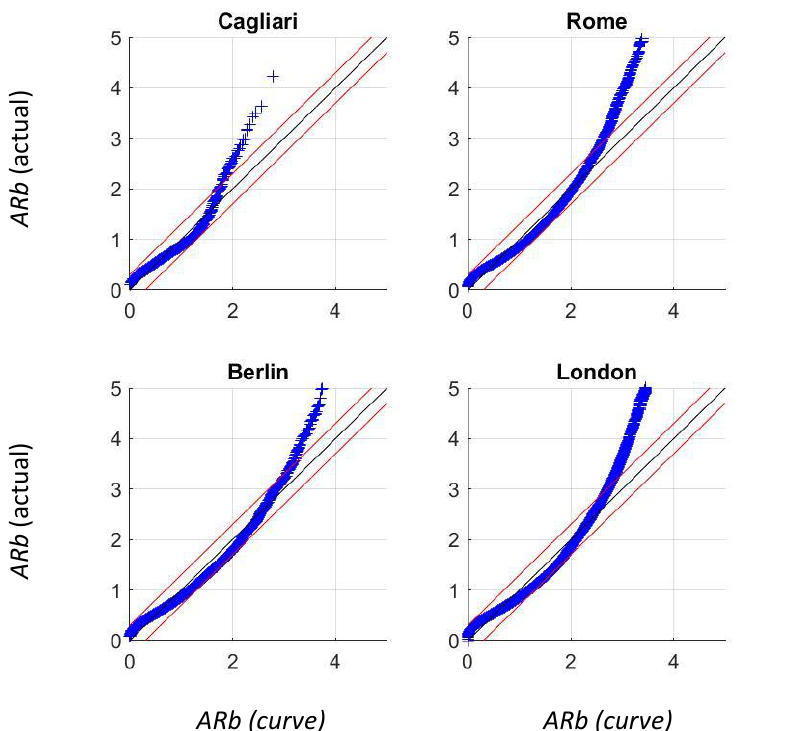
Figure 12. Q-Q plots for ARb ; actual data on the Y -axis, best-fit curves on the X -axis; the black line is the bisector, the two red straight lines highlighting a tolerance interval.